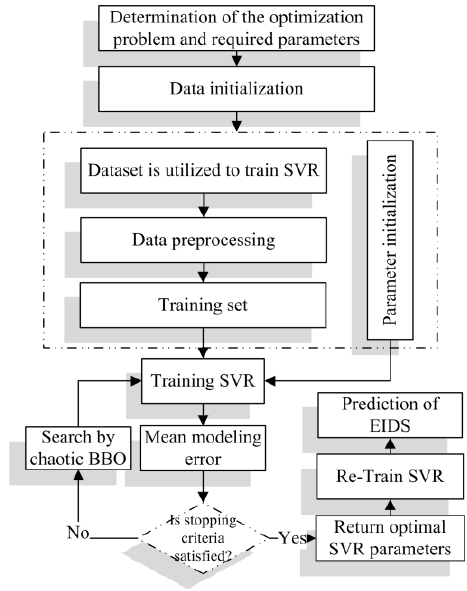
Figure 1. The SVR-CBBO